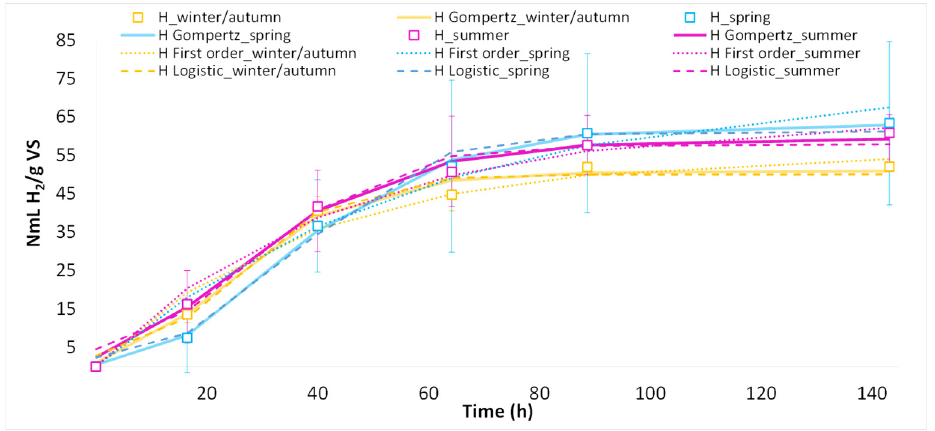
Figure 1. Cumulative H 2 production, modified Gompertz, the first-order, and the modified Logistic model using the three different fruit and vegetable waste mixtures; one per season were considered. RMSE and R 2 were used to evaluate the outcomes of model fitting (Table 4), showing that the Gompertz model minimizes the errors for all seasons and with an R 2 > 0.99. Table 4. Statistical analysis of the three compared models describing H 2 production of three different fruit and vegetable waste